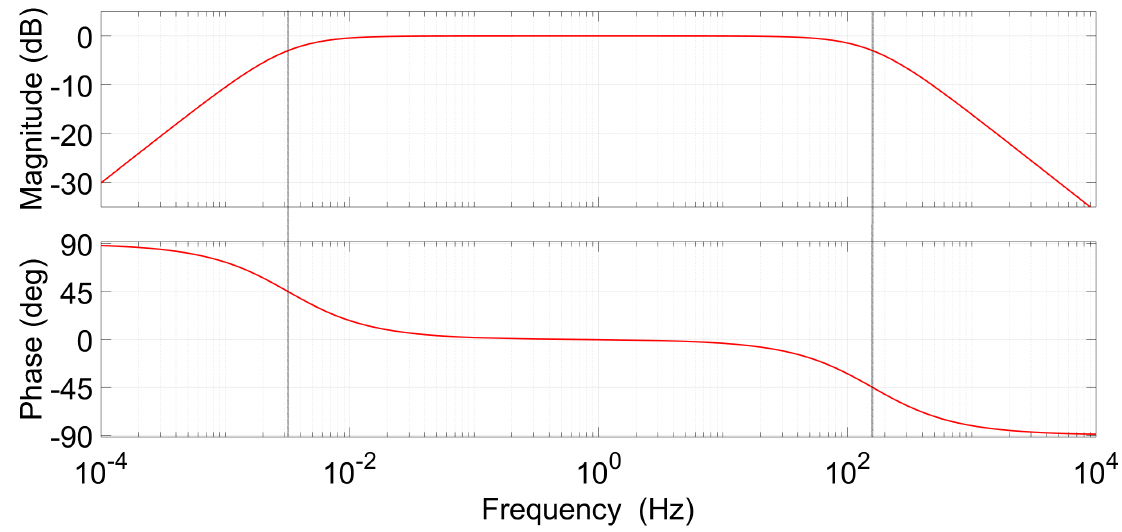
Figure 2. Frequency response of the low-pass filter combined with the wash-out filter when K t = 1, T lp = 0.001 s, T r = 50 s. This combination is equivalent to a band-pass filter.